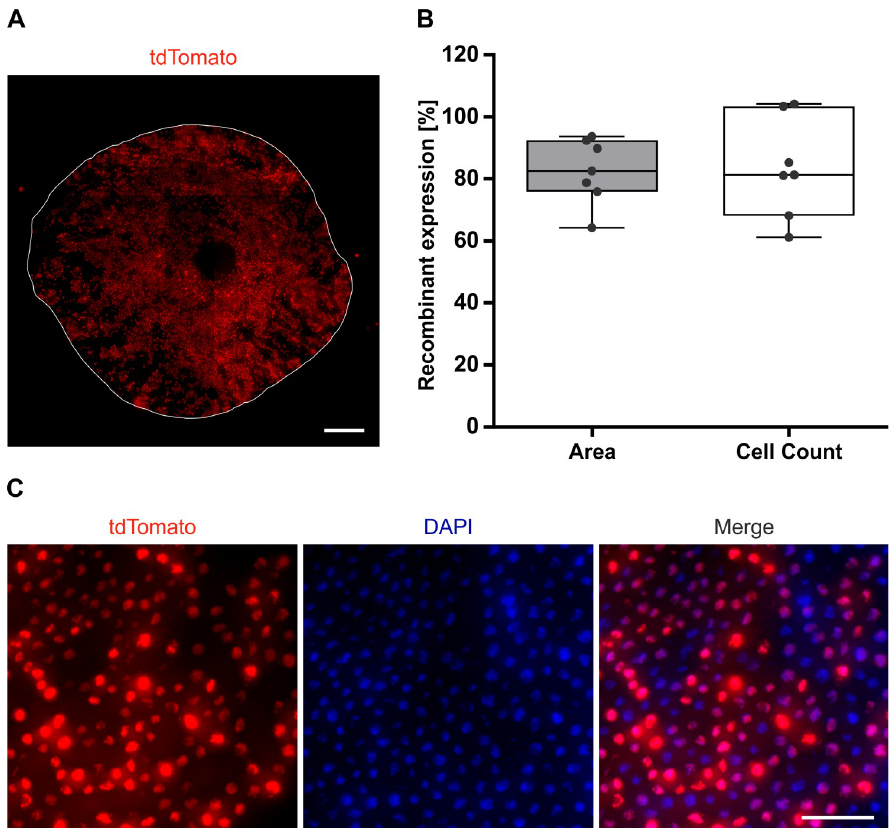
Fig 6. Analysis of the Cre-mediated recombinant expression in embryonic Ai14;RPE-Tyrosinase-CreEr T2 mice. A: Fluorescent flatmount image showing the uniform distribution of tdTomato expressing cells throughout the RPE of an E17.5 Ai14;RPE-Tyrosinase-CreEr T2 embryo. Outline of the RPE indicated by the solid line. B: Upon quantification method, recombinant expression in embryonic mice was 82.5% (Area) and 83.5% (Cell Count), respectively (n = 7 eyes). C: Representative fluorescent flatmount images showing tdTomato expression and DAPI staining of an E17.5 Ai14;RPE-Tyrosinase-CreEr T2 RPE. Scale bar: (A) 200 μ m, (C) 50 μ m.